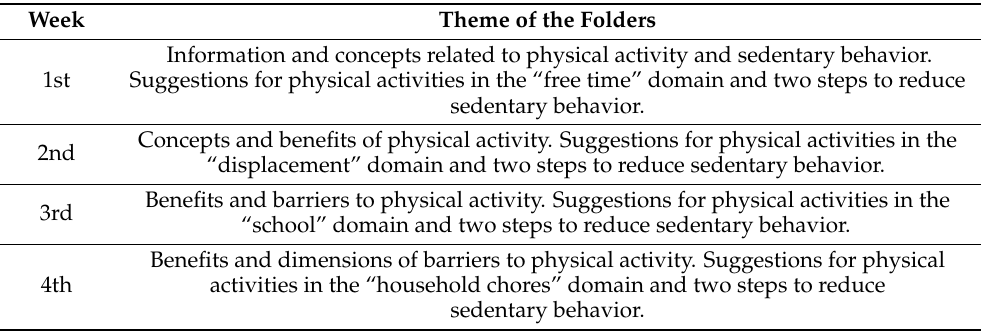
Table 1. The theme of the folders sent to the participants per